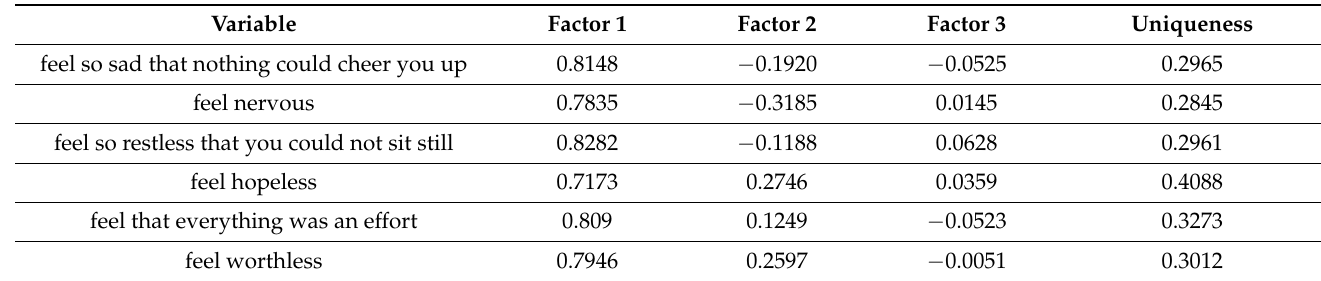
Table 4. Exploratory factor analysis of distress.